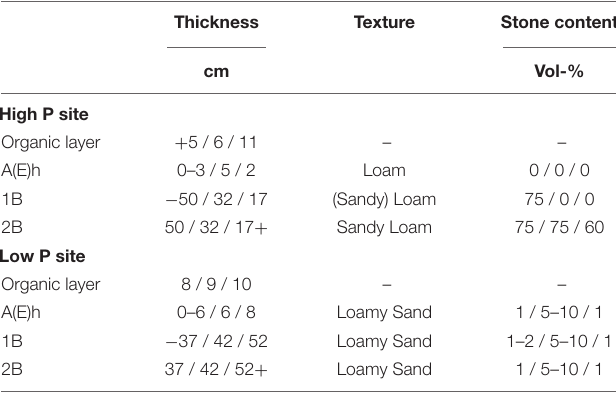
TABLE 2 | Soil properties of the two study sites Mitterfels (high P site) and Lüss (low P